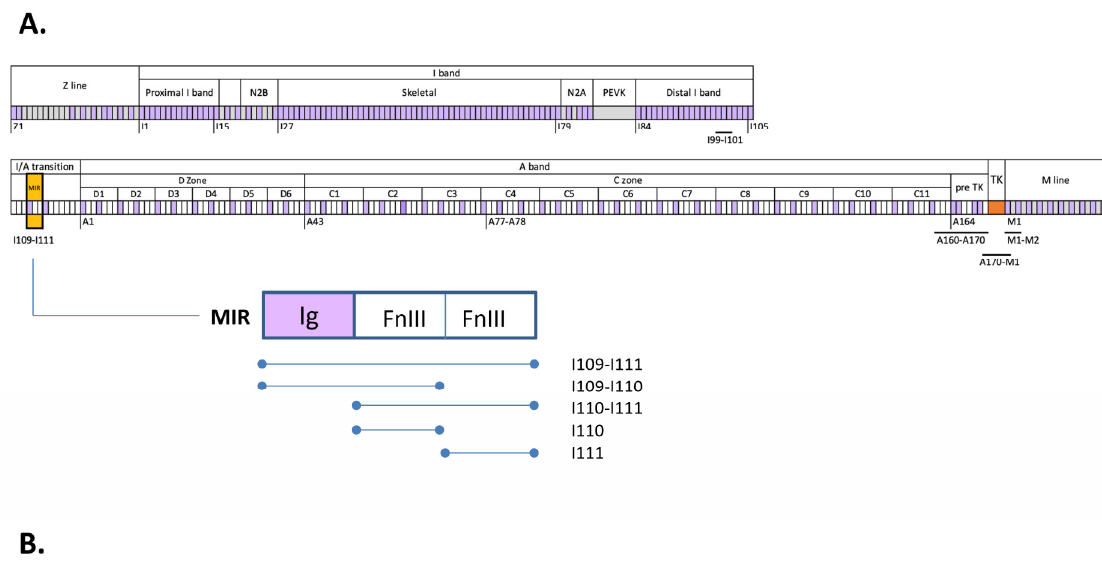
Figure 1. Schematic representation of the domain composition of titin and fragments used in the present study. ( A ) Domain composition of titin. Fibronectin domains are shown in white, Ig domains in purple and unique sequences in grey. Titin kinase (TK) is in orange. Titin sarcomeric regions and A-band super-repeats are annotated. The first domain of each zone is numbered. Segments studied in this work are underlined. The MIR segment and its constituents studied in this work are shown; ( B ) Amino acid sequence of I110 and its corresponding 9 synthetic peptides in this work (horizontal thin lines under the sequence).